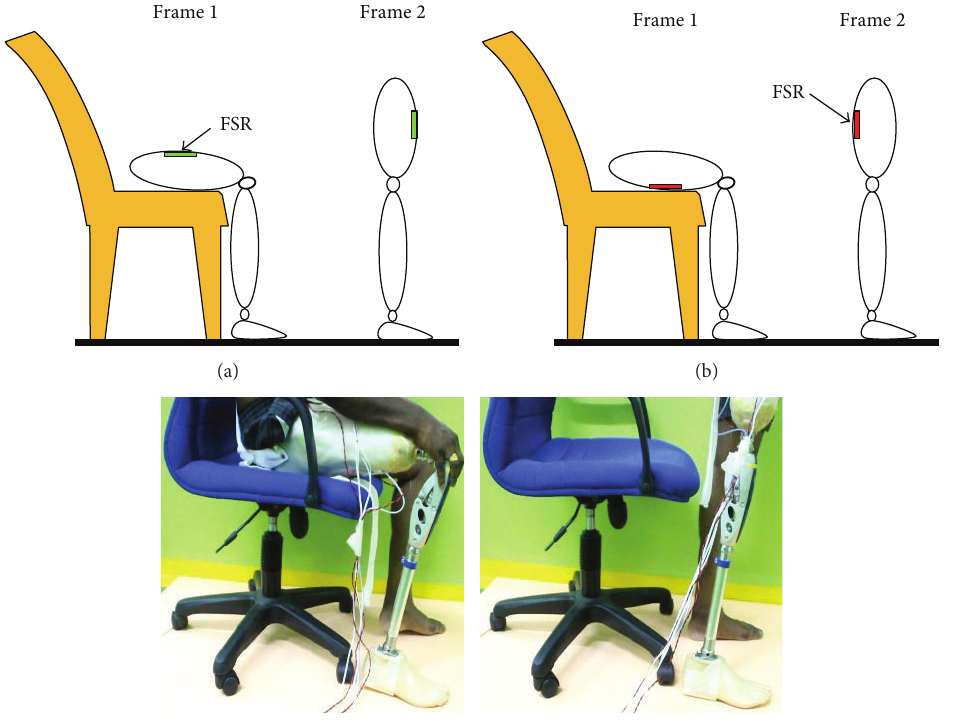
Figure 6: (a) Anterior FSR placement during sit to stand; (b) posterior FSR placement during sit to stand; and (c) the individual performing sit to stand while wearing the FSR instrumented